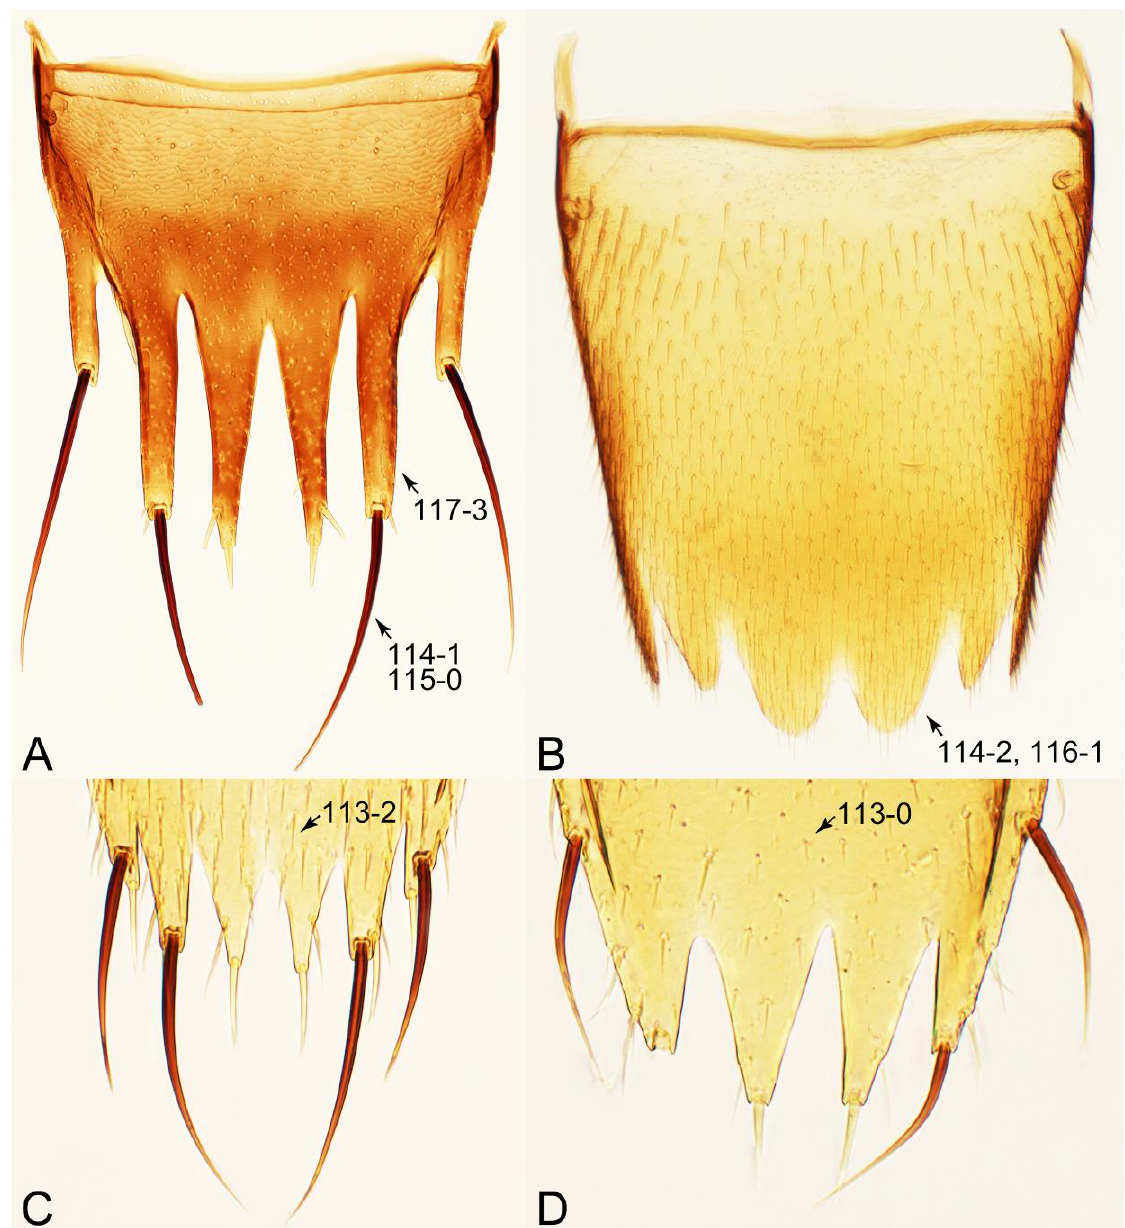
Figure 31. Photographs of body parts of Vatesini, tergite VIII, enlarged. ( A ) Cilea limbifera , female, dorsal view. ( B ) Vatesus gigas , male, dorsal view. ( C ) Mimocyptus sp., female, dorsal view. ( D ) Coproporus colchicus , female, dorsal view. Characters and character states (format X-X) are indicated on each